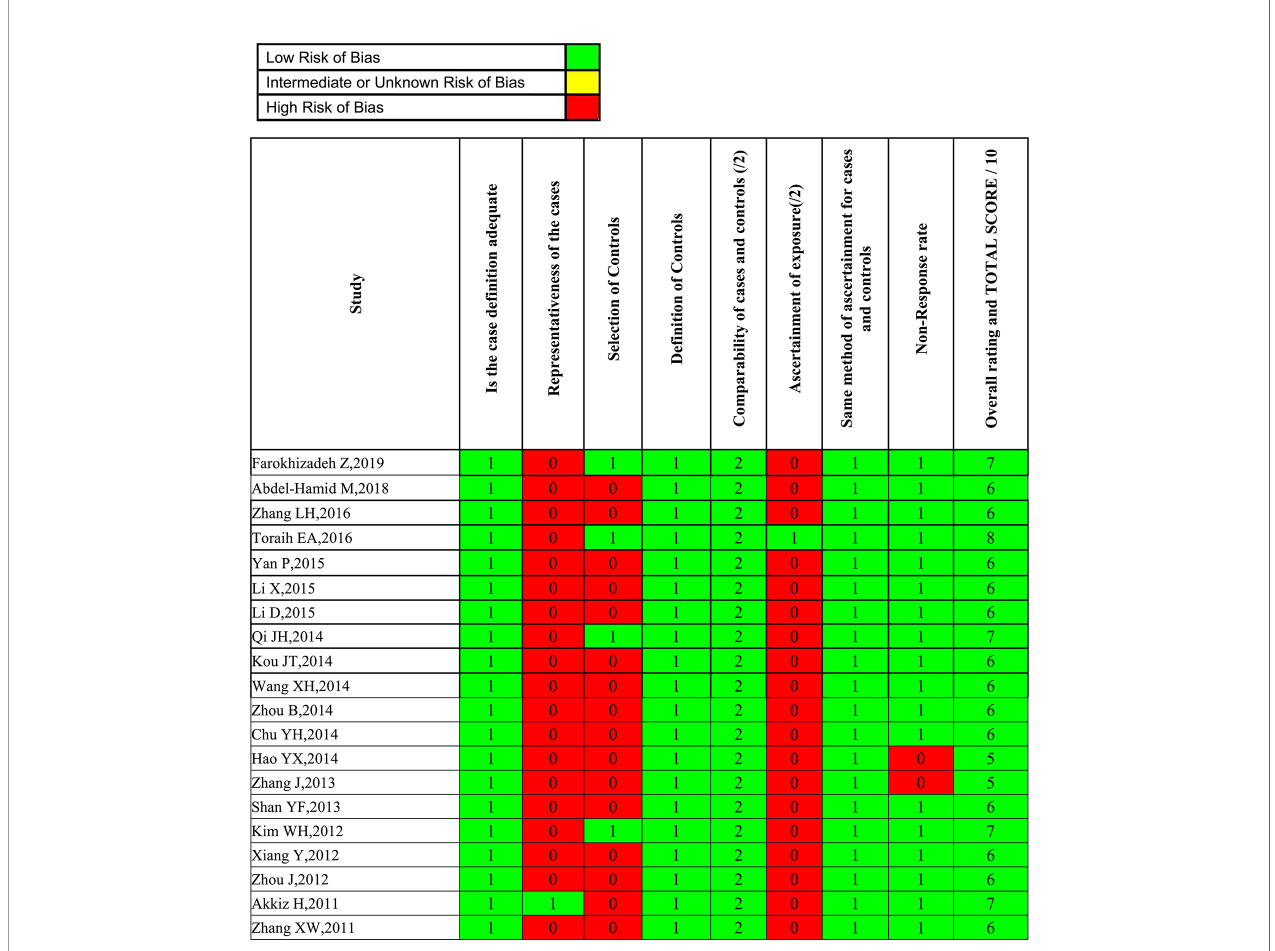
FIGURE 2 | Risk of bias assessment using the Newcastle-Ottawa Scale for case-control